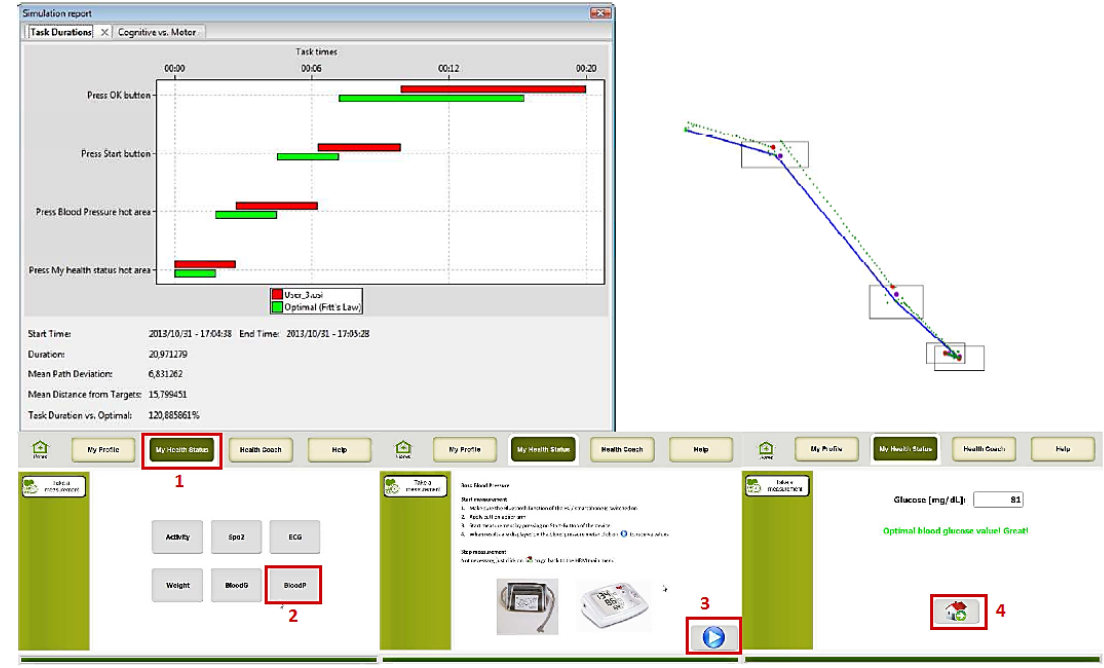
Figure 15. User 3 Cognitive VUM simulation: Take measurements (blood pressure).